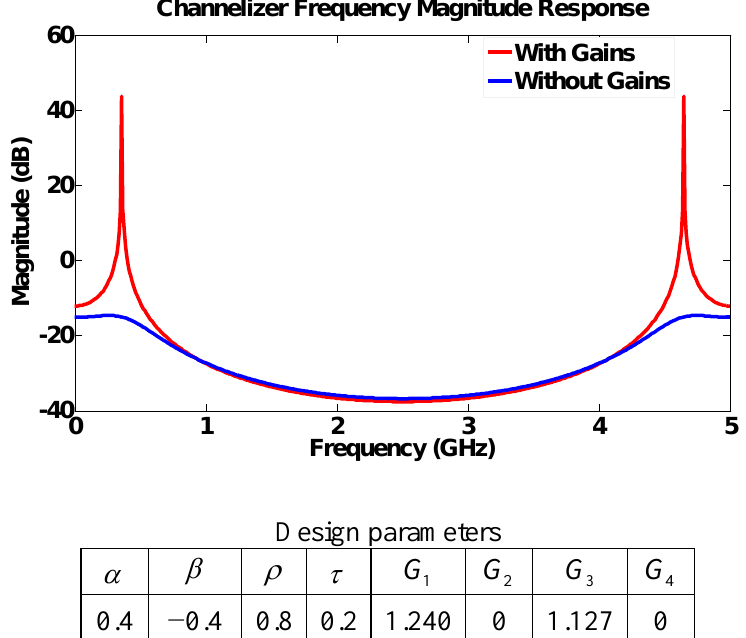
Figure 12. Frequency response of output 4 for structure III with some unused gains, resulting in a resonator